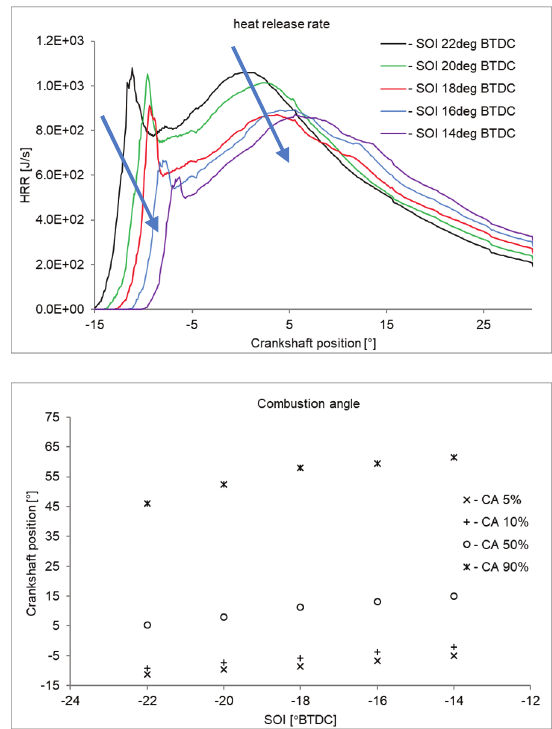
Fig. 2. The heat release rate and the combustion characteristics